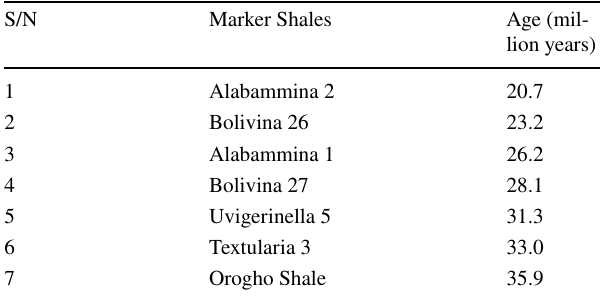
Table 1 Marker shales and ages provided from forams interpretation in the study